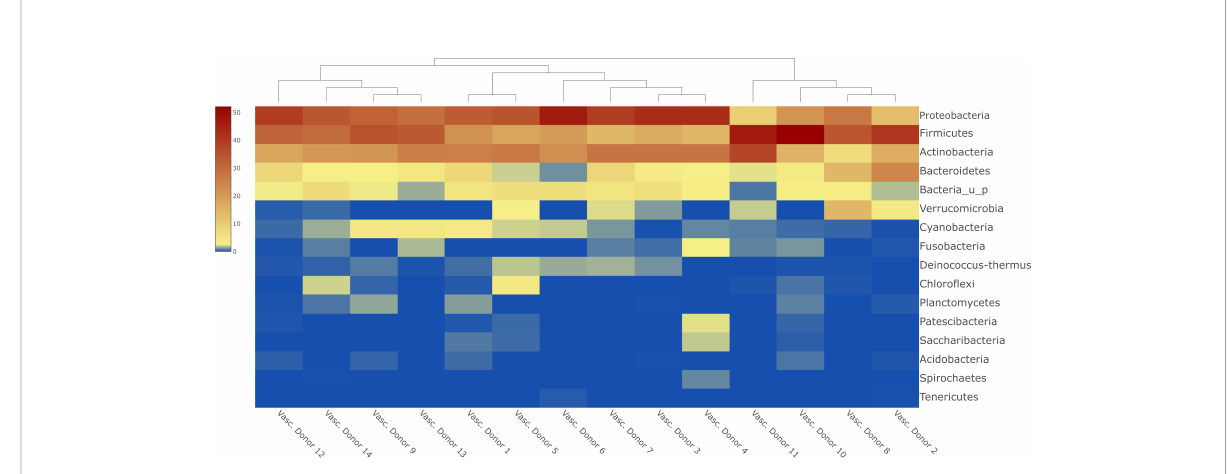
FIGURE 1 Heatmap about the most abundant phyla in human vascular samples with sample clustering